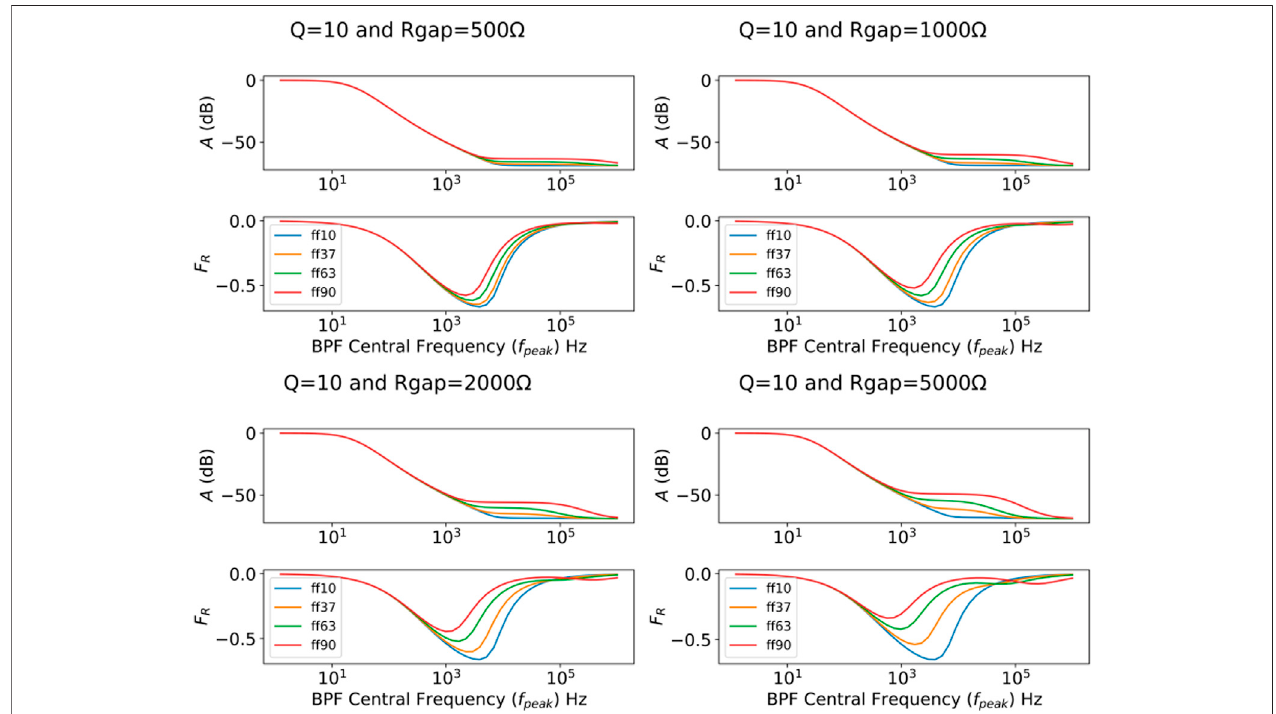
FIGURE 5 | Oscillation-Based (OB) parameters for different values of R gap , and Q f (cid:2) 10. The simulations are performed over different fi ll factor levels (10%, 37%, 63%, and 90%).